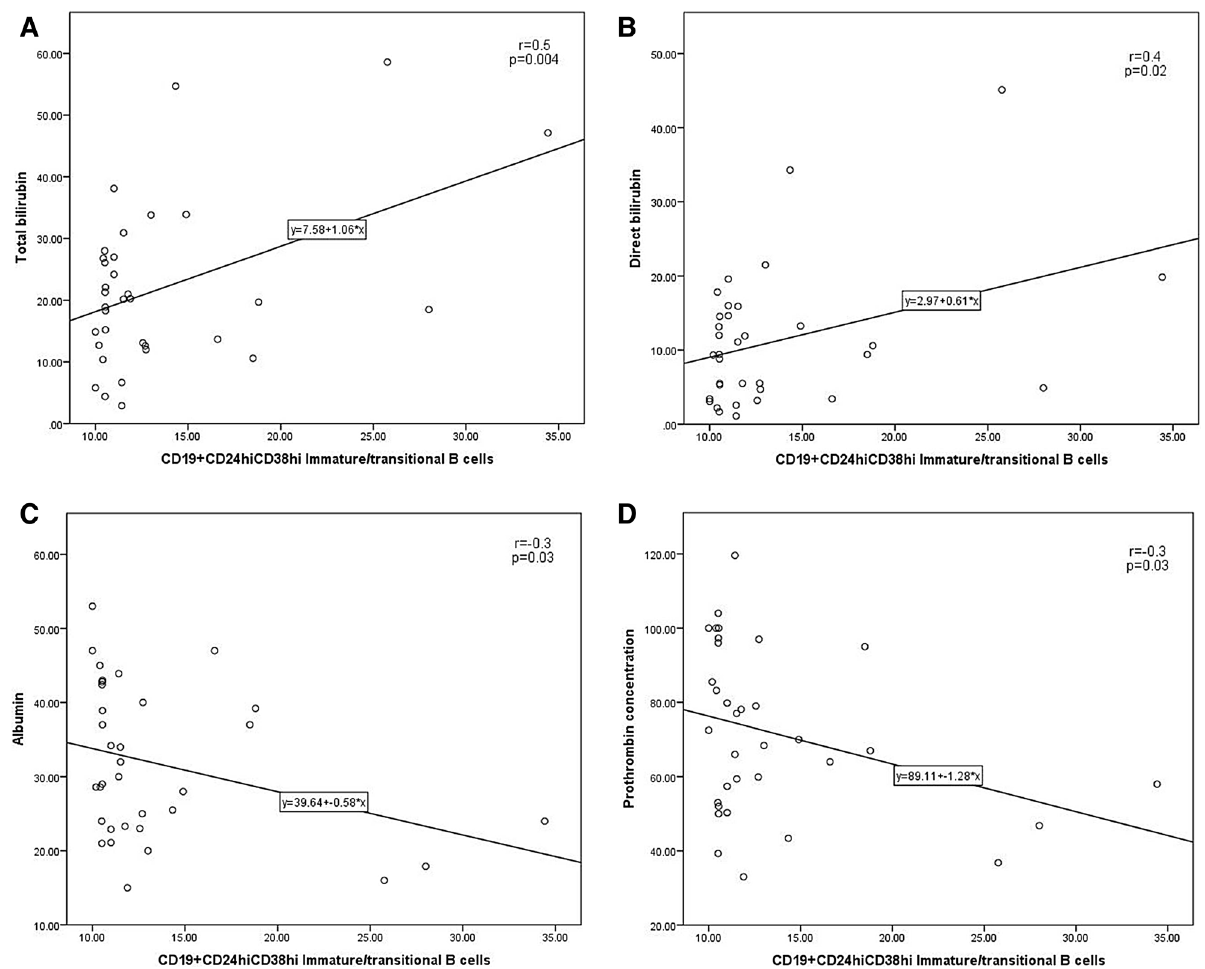
Figure 2. Correlations of CD19 + CD24 hi CD38 hi Immature/transitional B cells with ( A ) total bilirubin, ( B ) direct bilirubin, ( C ) Albumin and ( D ) prothrombin concentration in the diabetic CHC